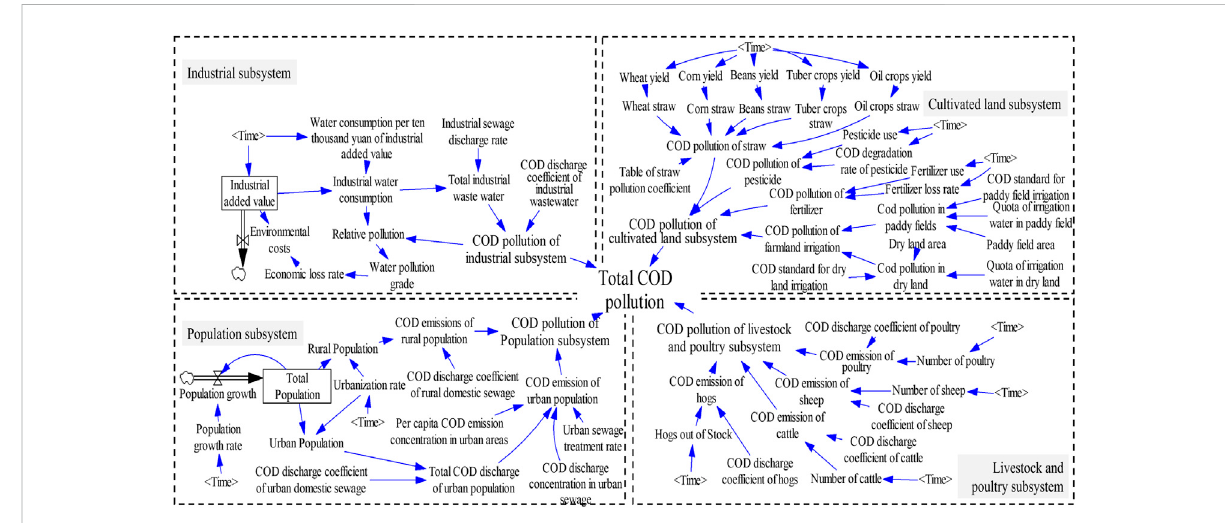
FIGURE 2 Simulation model of the urban water pollution